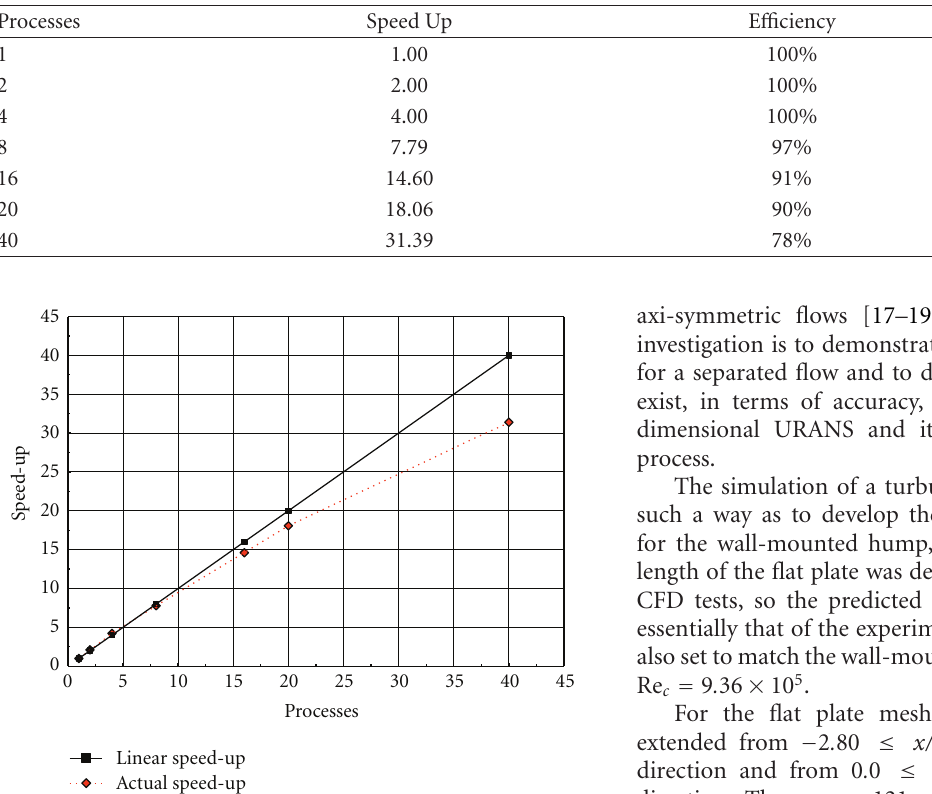
Table 1: Typical speed-up and e ffi ciencies.